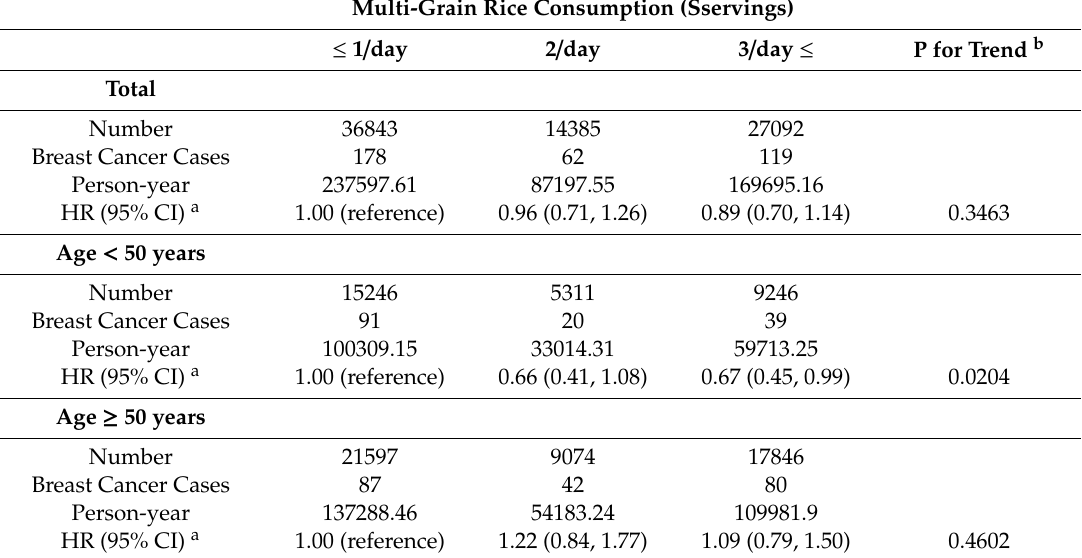
Table 6. Hazard Ratios (HR) and 95% Confidence Intervals (CI) of Breast Cancer according to Multi-Grain Rice